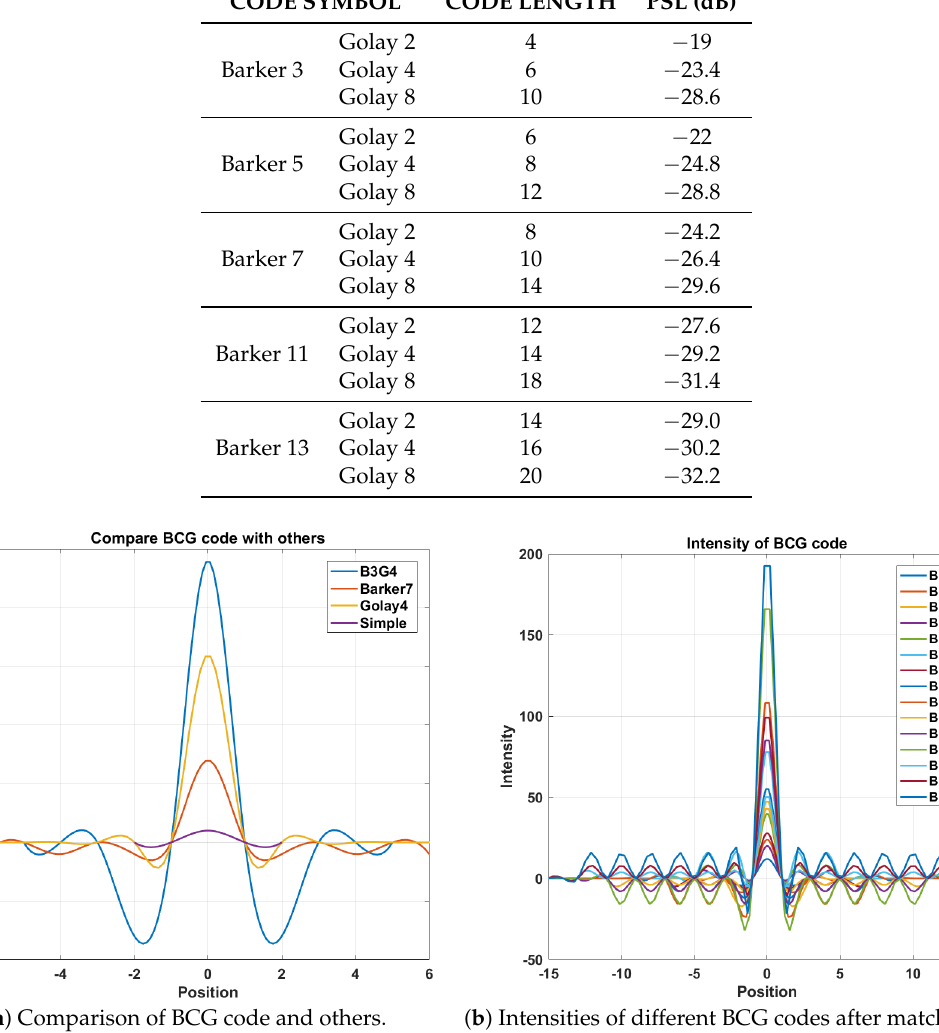
Figure 4. The theoretical simulation results. ( a ) The 3-bit Barker code combined 4-bit Golay code compared to simple pulse, 7-bit Barker code and 4-bit Golay code. ( b ) the theoretical intensity comparison of 15 different types of BCG